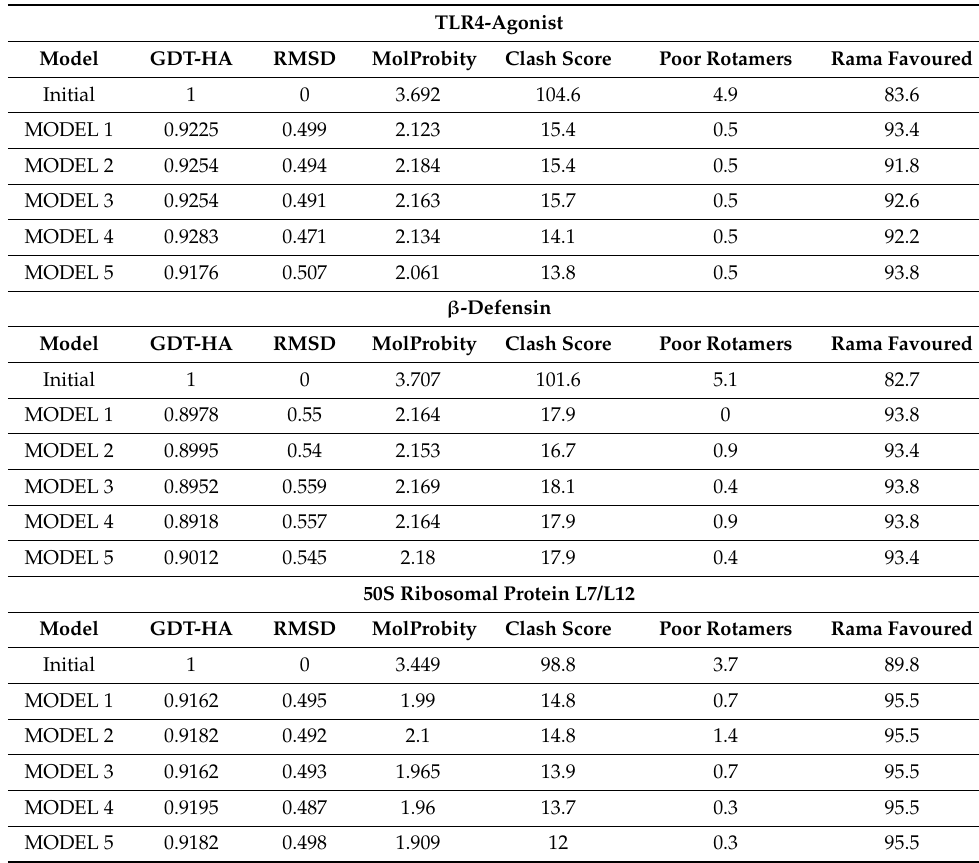
Table 2. Physical parameters for validation of final subunit vaccine